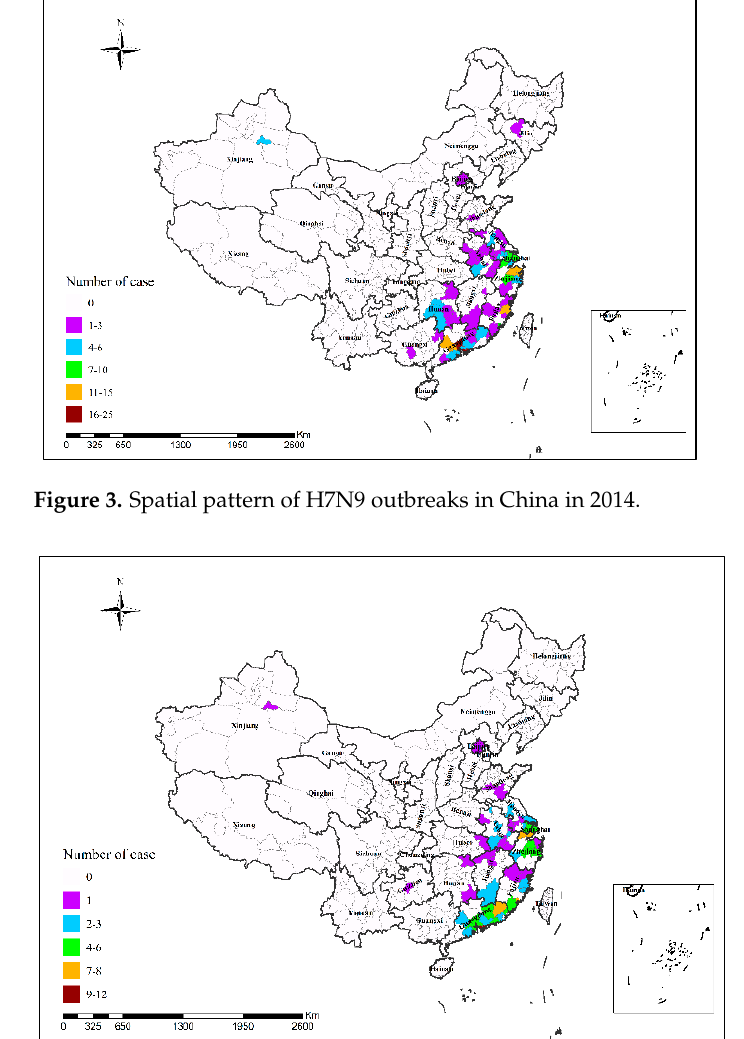
Figure 4. Spatial pattern of H7N9 outbreaks in China in 2015.